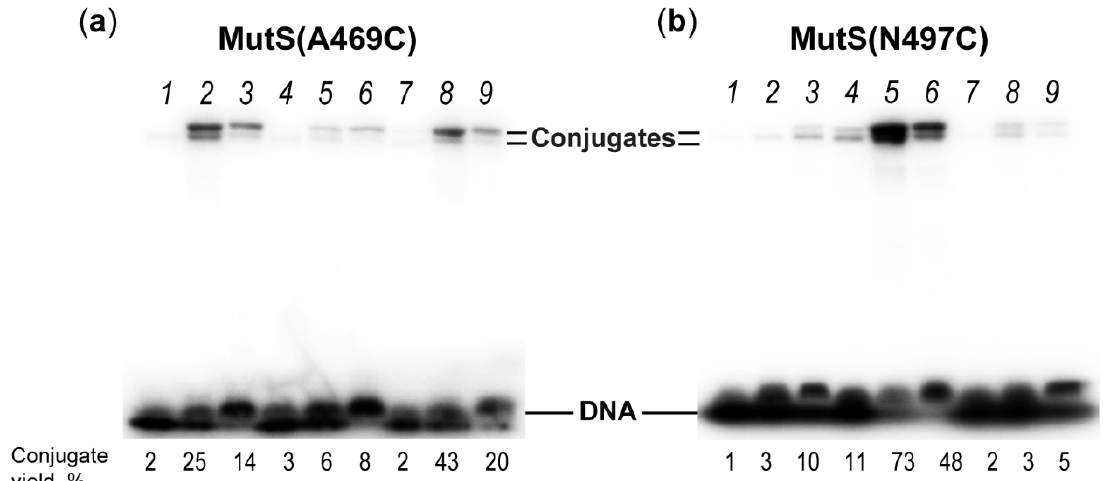
Figure 6. MutS(N469C) ( a ) or MutS(N497C) ( b ) cross-linking with 17GT-dU sacryl -5 , 17GT-dU macryl -5 or 17GT-dU lacryl -5 (lanes 1 – 3 ); 17GT-dU sacryl -8 , 17GT-dU macryl -8 or 17GT-dU lacryl -8 (lanes 4 – 6 ); or 17GT-dU sacryl -11 , 17GT-dU macryl -11 or 17GT-dU lacryl -11 (lanes 7 – 9 ). Conjugate yields (%) are indicated under the gel lanes. Protein concentration on the monomer basis was 5 µM, DNA: 0.5 µM. Duplexes contain a 32 P label at the 5 ′ end of the modified strand. Autoradiograph of SDS-PAGE in an 8% gel.